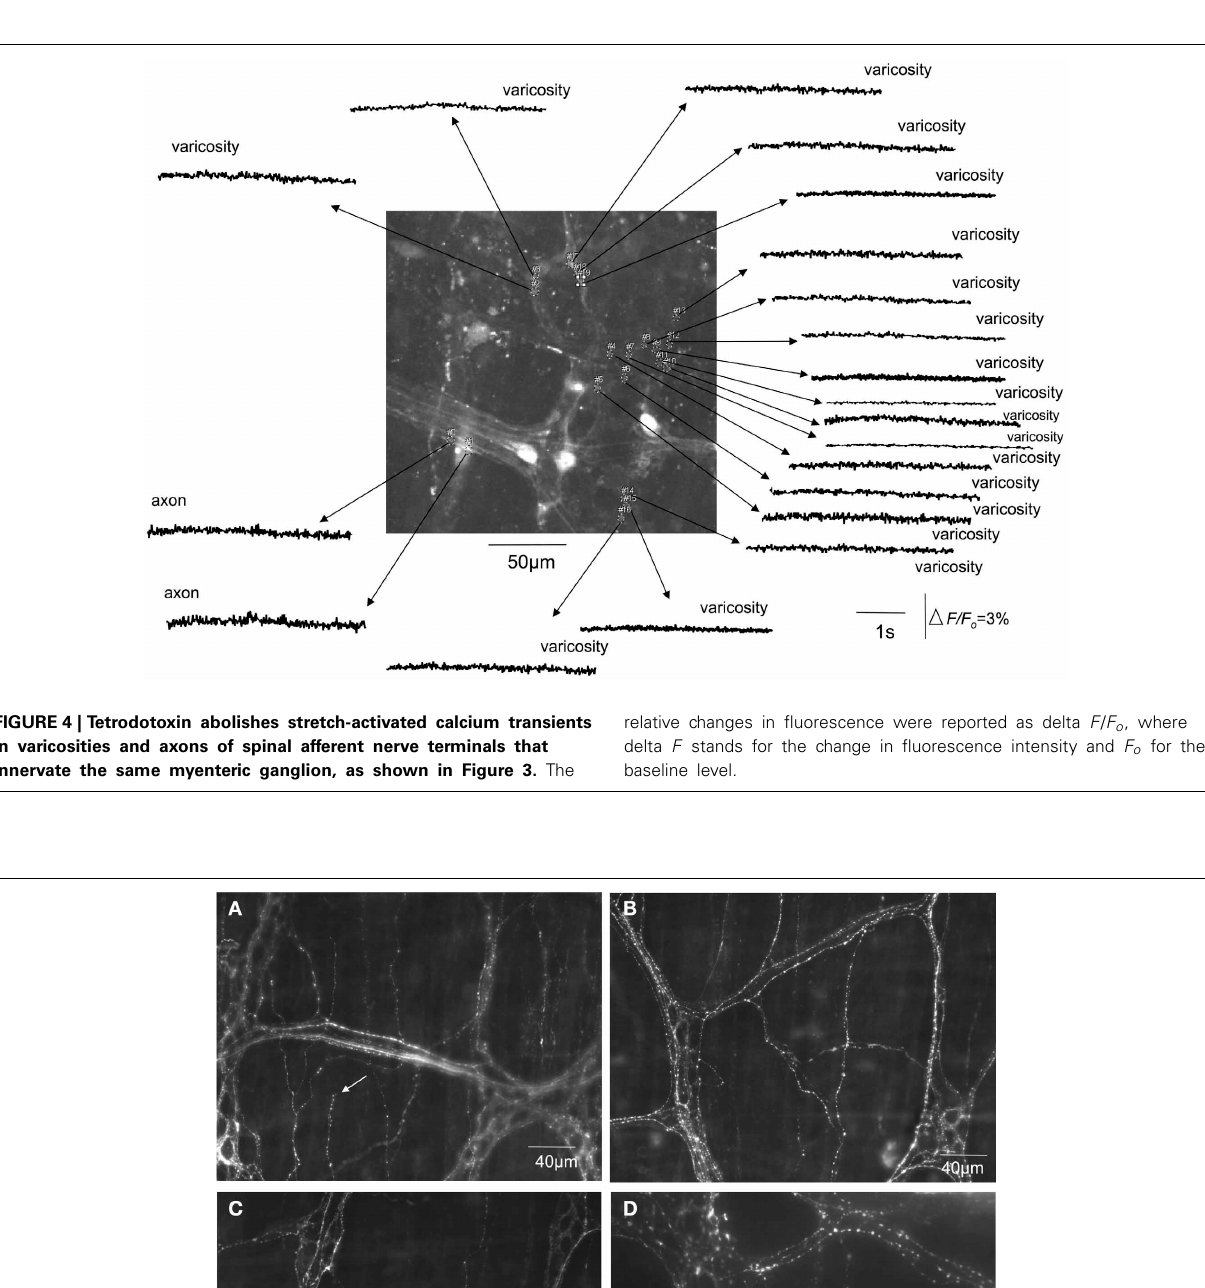
FIGURE 5 | TRPV1 immunoreactive nerve endings identified in mouse colonic myenteric ganglia and circular smooth muscle. (A–C) Show dense TRPV1 varicose fibers innervate myenteric ganglia and circular muscle. The arrow in (A) shows the ending of a varicose